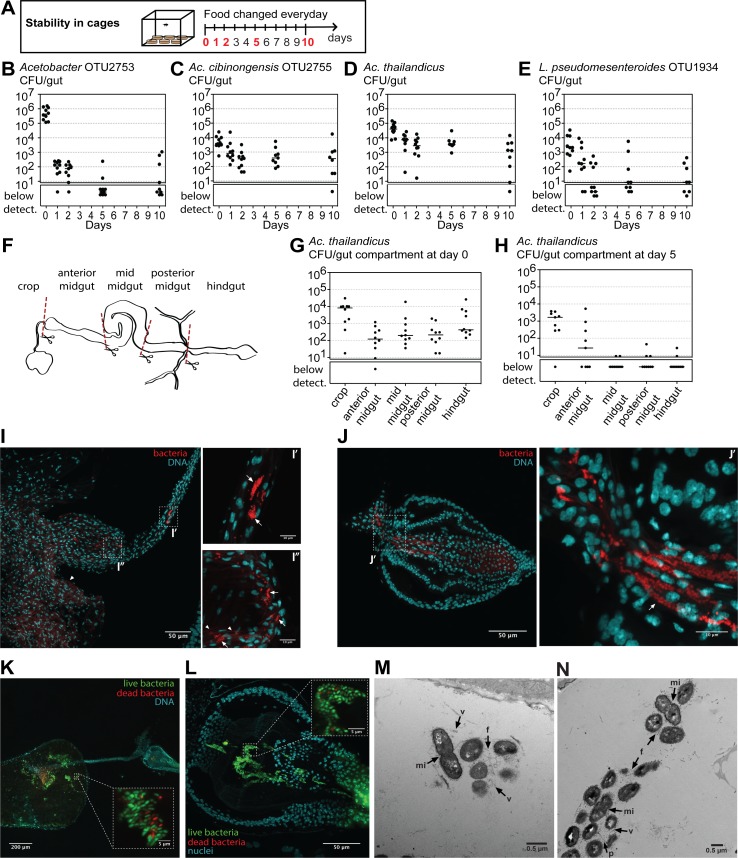
Acetobacter thailandicus stably persists in the foregut of Drosophila melanogaster.(A–E) Stability of different bacteria in monoassociation. Single 3–6-day-old w1118
iso males from monoassociated stocks, with Acetobacter OTU2753 (B), A. cibinongensis (C), A. thailandicus, (D) or Leuconostoc pseudomesenteroides (E), were exposed to the stability protocol in cages, as shown in the scheme (A). Number of CFUs in individual guts was assessed by plating at Days 0, 1, 2, 5, and 10 of the protocol. Stability of different bacteria was analyzed by fitting the data to an exponential decay model represented in S5I Fig. Supporting data can be found in S7 Data. (F–N) Localization of A. thailandicus in the gut. (G–H) Number of CFUs in each gut compartment from w1118
iso males monoassociated with A. thailandicus before (G) and after (H) 5 days of the stability protocol. Guts were dissected and cut according to the scheme in (F). Each dot represents one gut or one gut fragment and lines represent medians; statistical analyses were performed together with replicate experiments shown in S6 Fig. Supporting data can be found in S8 Data. (I, J) Fluorescent in situ hybridization with Cy3 labeled Bacteria 16S rRNA universal probe EUB338 in the gut of males monoassociated with A. thailandicus, after 5 days of the stability protocol. A. thailandicus persists in the crop duct (I′), the crop (I″), and the proventriculus (J and J′). In the crop, A. thailandicus cells are observed close to the chitin (I″). Chitin autofluorescence is indicated by white arrowheads and bacteria by white arrows. (K, L) Live/dead staining in the crop (K) and proventriculus (L) of males monoassociated with A. thailandicus 9 days after the stability protocol. Live bacteria stained with SYTO9 (green) and dead bacteria with propidium iodide (red). (I–L) DNA was stained with Hoechst. (M–N) Aggregates of A. thailandicus observed by transmission electron microscopy in the lumen of the proventriculus. Some cells present membrane invaginations (mi) and seem to be dividing. Cells appear to be attached to each other by external appendages such as fimbriae (f). A pili-like structure is also present (p). Extracellular vesicles are found between cells (v). Scale bar corresponds to 200 μm in (K), 50 μm in (I, J, L), 10 μm in (I′, I″, J′), 5 μm in the zoom in panels of (K, L), and 0.5 μm in (M, N). CFU, colony-forming unit; Cy3, cyanine 3 dye; mi, membrane invagination; OTU, operational taxonomic unit; p, pili; v, vesicles; w1118
iso, w1118 DrosDel isogenic strain.